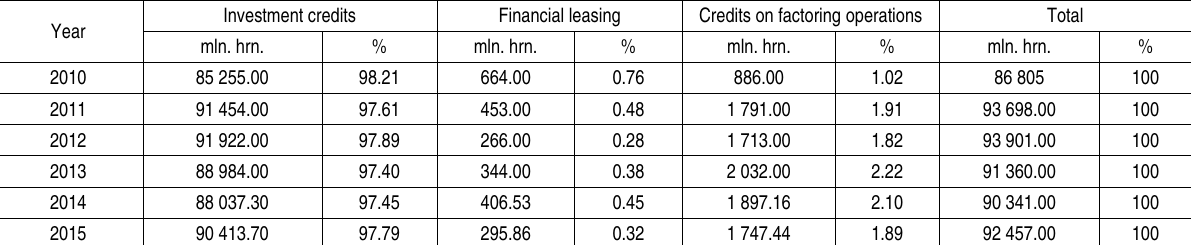
Table 2. The volume and structure of innovation directions credits provided by the banks of Ukraine in 2010-2015, mln.